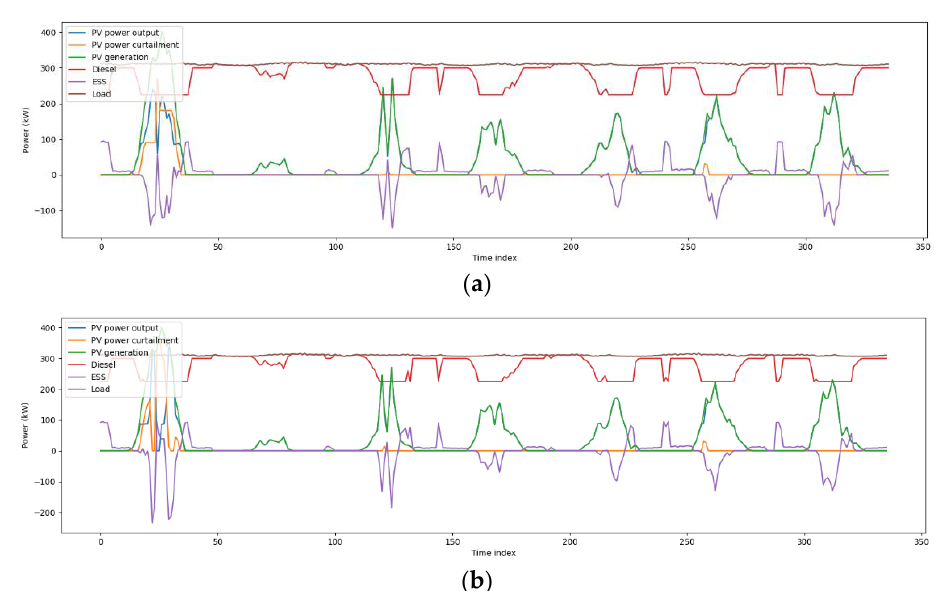
Figure 9. Simulation results of proposed method ( a ) and conventional method ( b ) for 7 days of September. September.